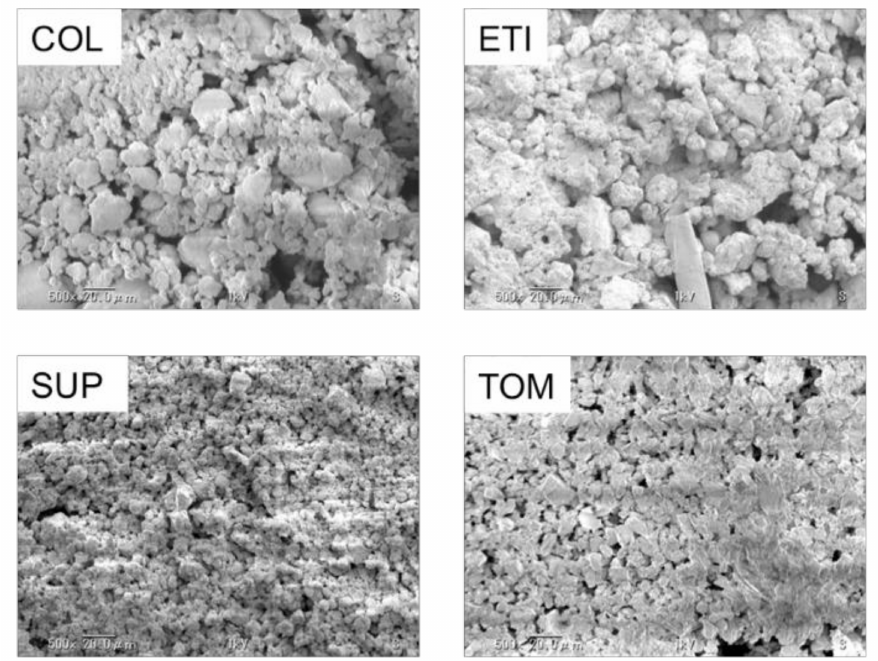
Figure 1. SEM images of abrasive particles in toothpastes, magnification of 500 ×